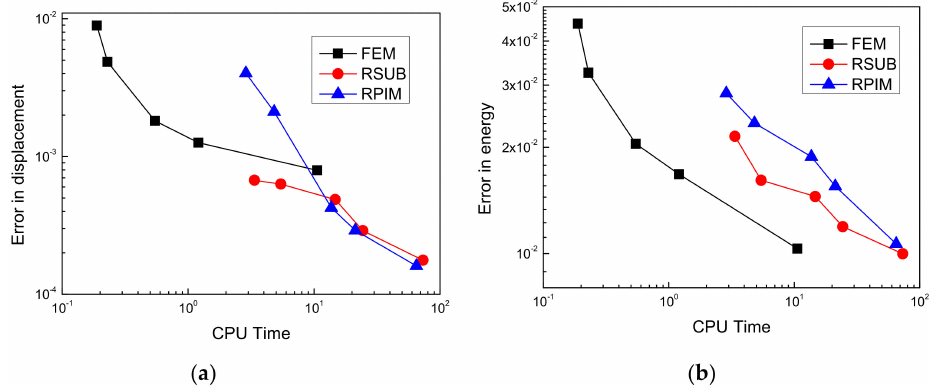
Figure 13. Computational e ffi ciency in the problem of the plate with a hole: ( a ) displacement; ( b ) energy.